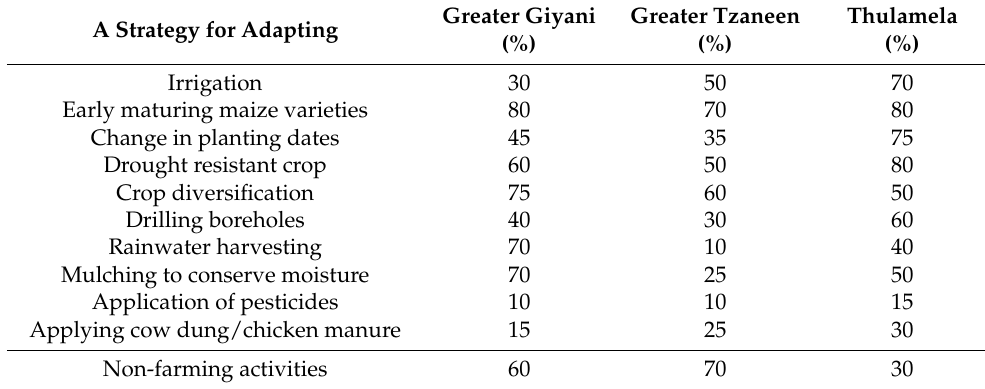
Greater Giyani Greater Tzaneen Thulamela (%) (%) (%)